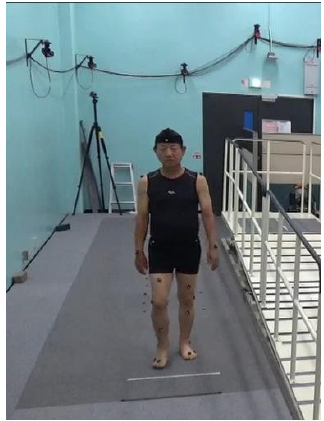
Figure 6. Helen – Hayes marker. Figure 6. Helen–Hayes marker.